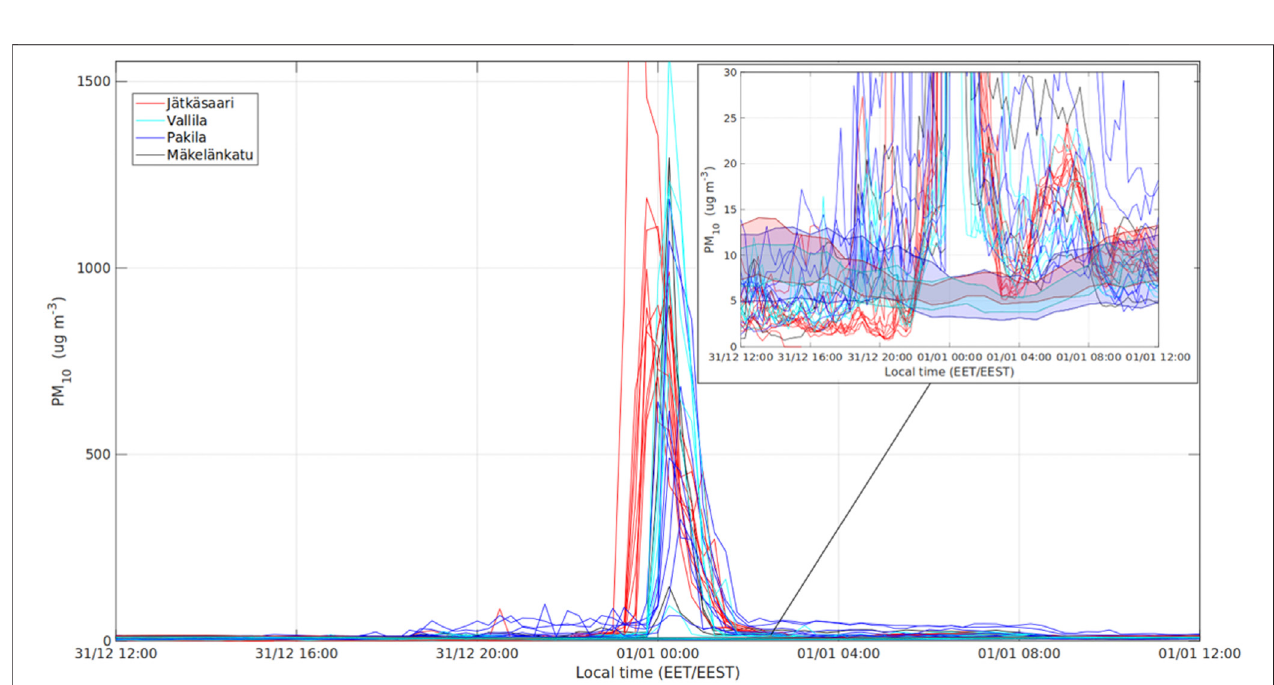
FIGURE 15 | PM10 mass concentration during the New Year celebrations as 15-min averages. Shaded areas show range of diurnal cycles in workdays (Mon-Fri) during 1.12.2020 – 31.1.2021 for sensors at different locations.